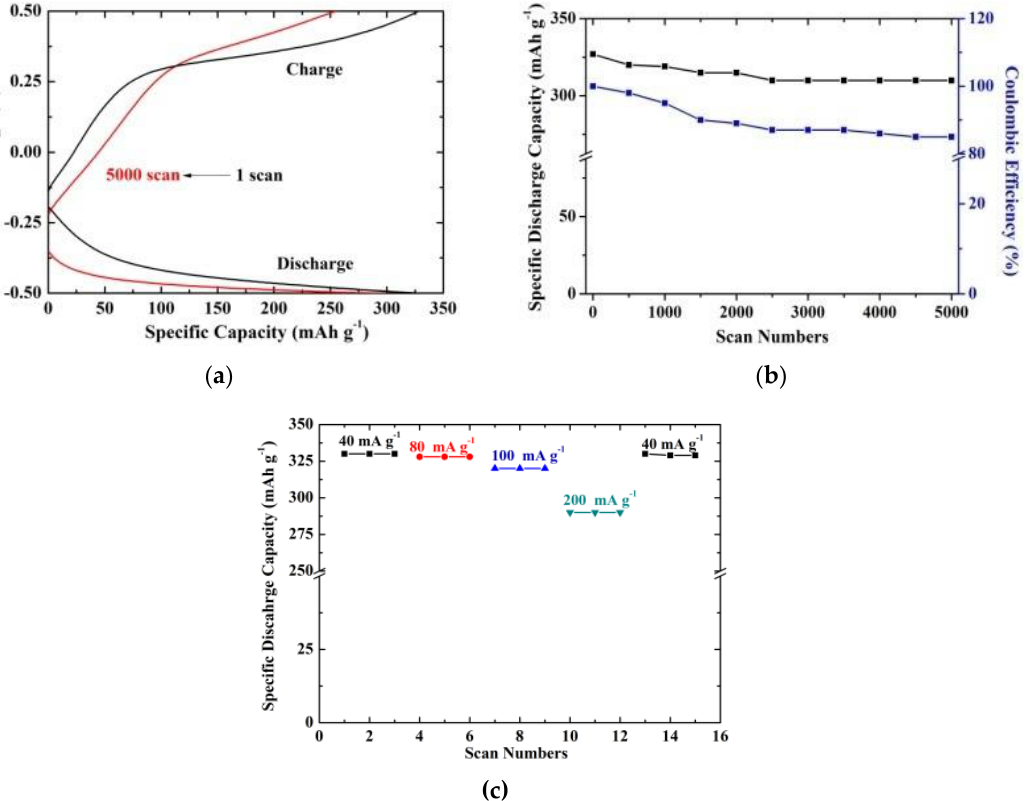
Figure 5. ( a ) The chronopotentiometric (CP) curves of ZnO/3D-printed graphene for −0.5 V to +0.5 V at 40 mA g −1 (the charge and discharge curves are indicated along with the 1st and the 5000th scan in black and red color, respectively); ( b ) Specific discharge capacity and coulombic efficiency of the anode material as a function of the scan numbers; ( c ) Rate capability of the composite at 40, 80, 100, 200 mA g −1 and then back to 40 mA g −1 . Table 1. Coulombic efficiency and specific discharge capacity of anodes taken from the literature.